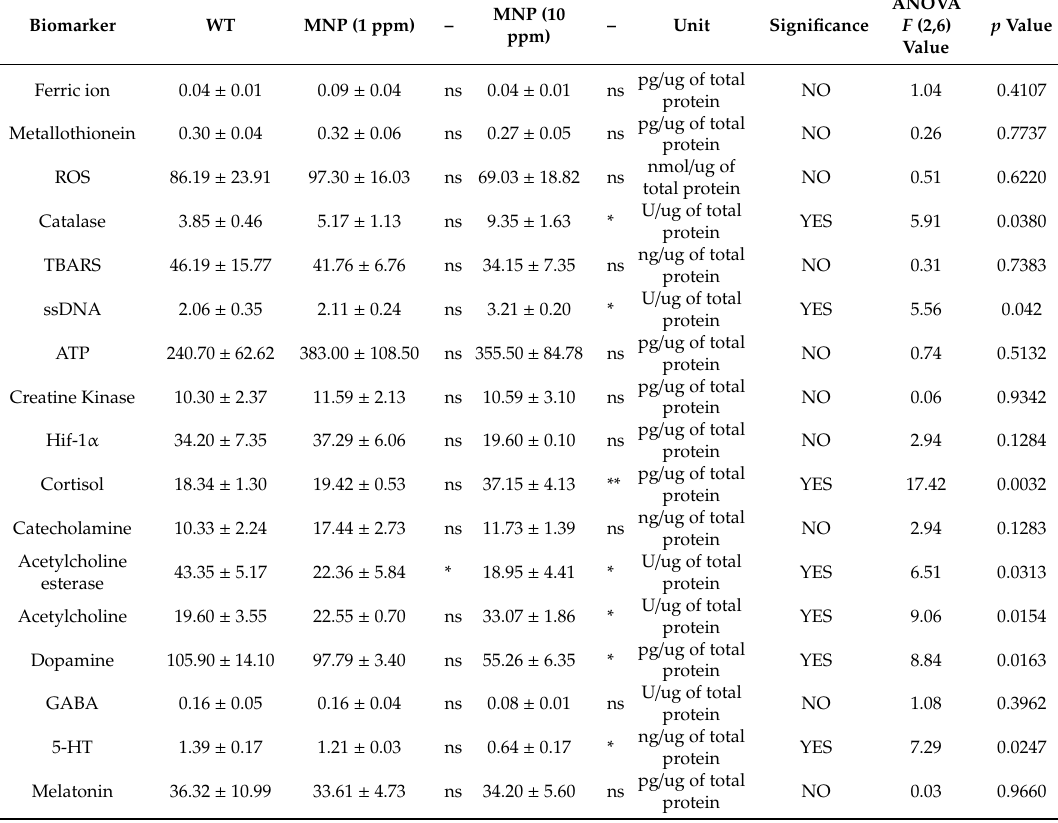
Table 1. Various biomarker analytes in the brain tissue for adult zebrafish are exposed to low and high doses of Fe 3 O 4 MNPs. The data were analyzed by one-way ANOVA and later subjected to post hoc significance analysis by using Dunnett’s multiple comparison